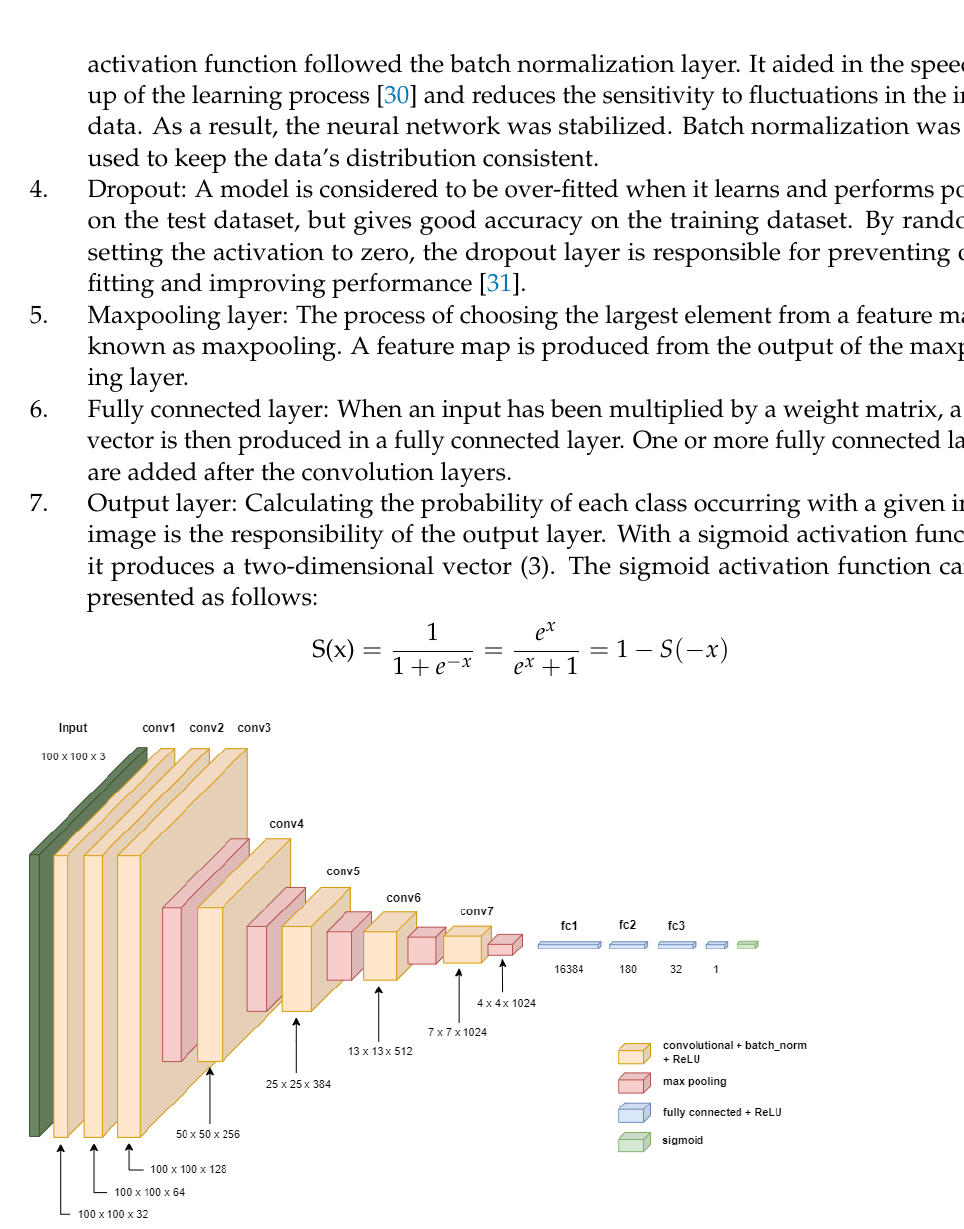
Figure 6. Proposed 4D